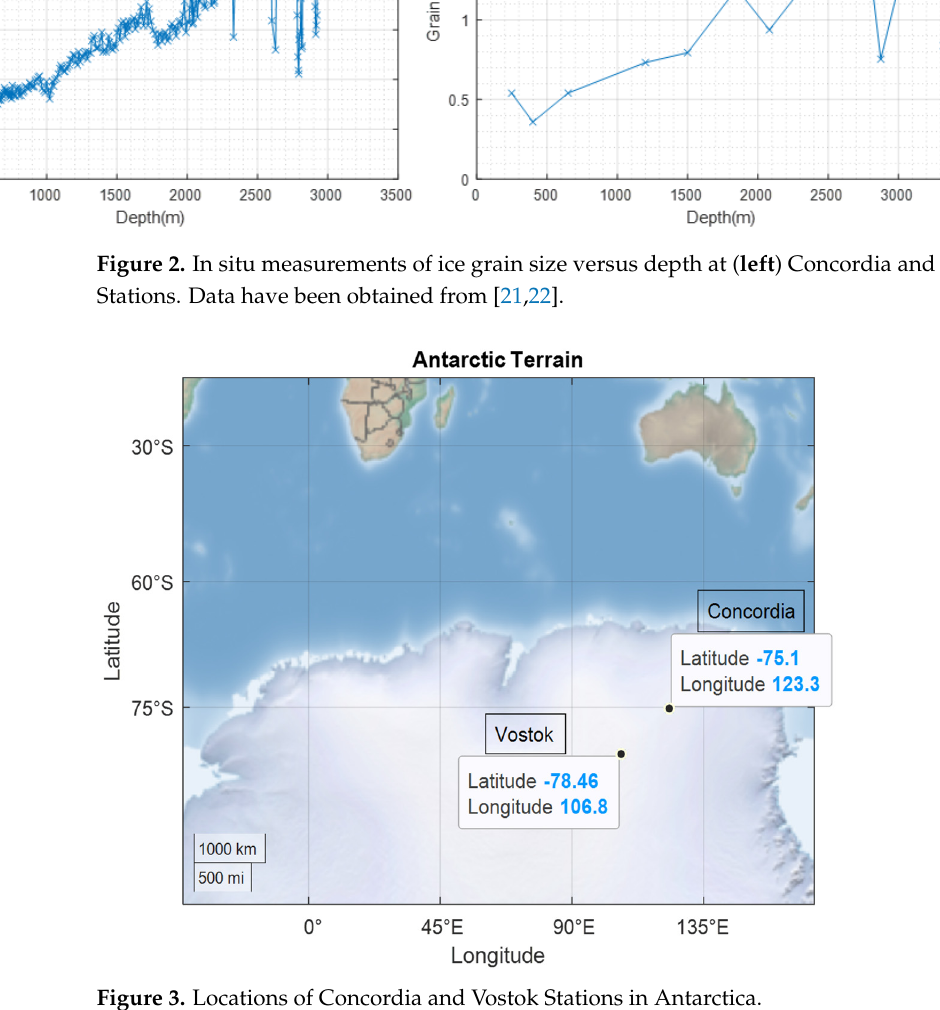
Figure 3. Locations of Concordia and Vostok Stations in Antarctica.